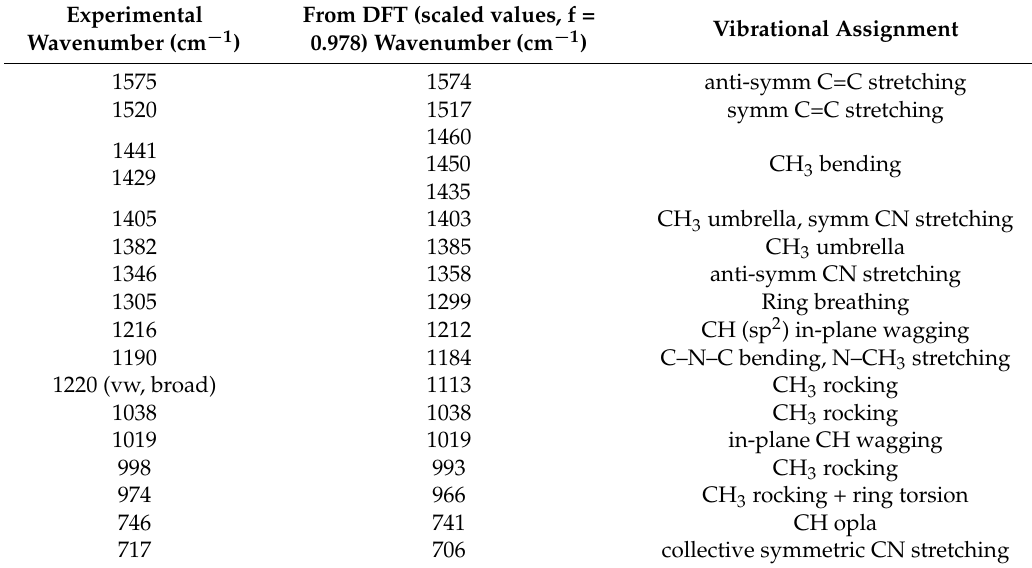
Table 1. Values of the wavenumbers corresponding to the absorption peaks of the most intense IR transitions: comparison between experimental and computed values (B3LYP/6-311++G(d,p)). Vibrational assignments are based on computed eigenvectors analysis.